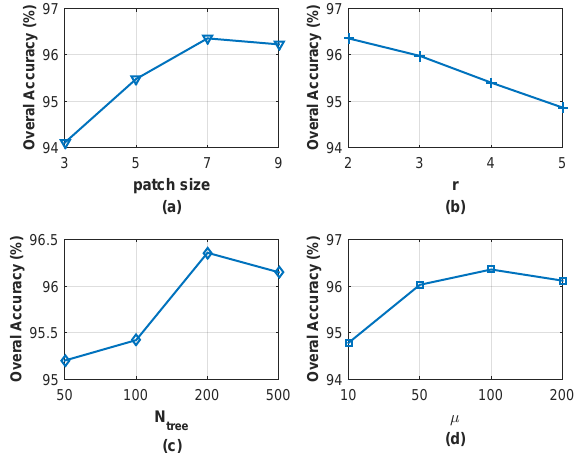
Figure 6. Sensitivity analysis of all the parameters. ( a ) Patch size. ( b ) Rank r . ( c ) Number of trees N tree . ( d ) Smooth parameter µ